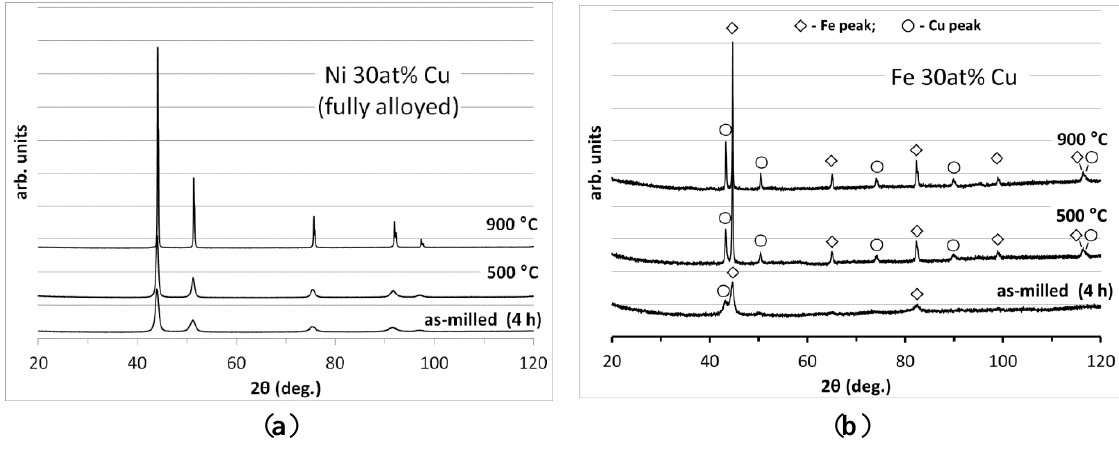
Figure 2. XRD patterns for samples milled for 4 h and then annealed at the given temperatures for ( a ) Ni 30 at% Cu and ( b ) Fe 30 at%